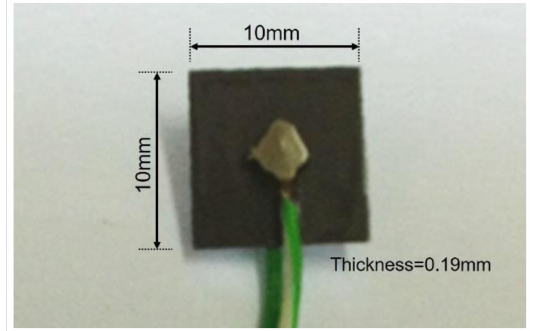
Figure 1. PZT patch used in this study.